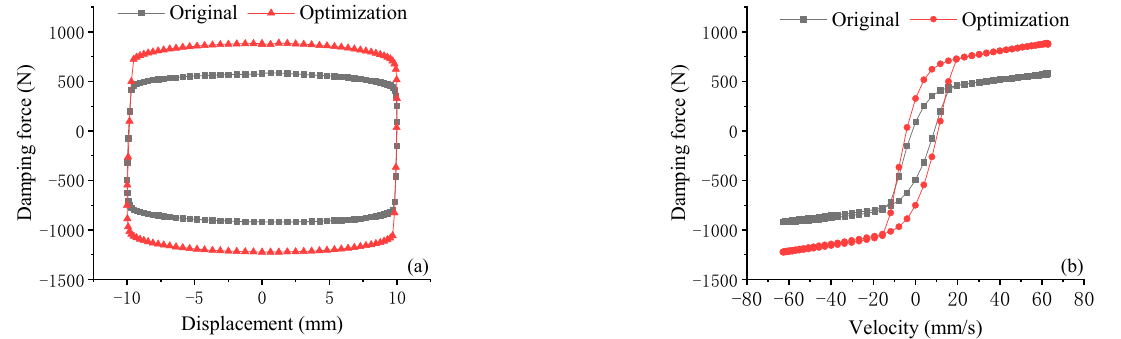
Figure 18. Damping characteristics before and after optimization: ( a ) damping force–displacement; and ( b ) damping force–velocity.